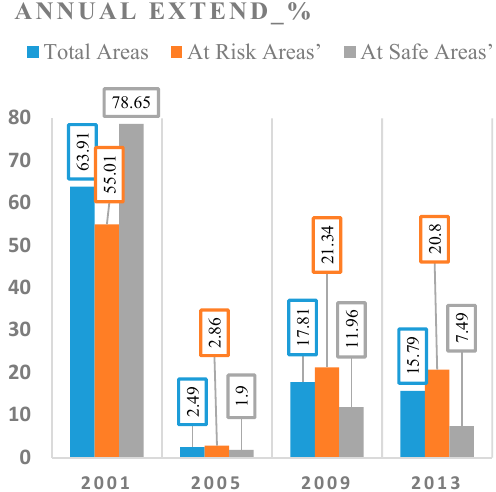
Figure 8. Urban areas from 2001 to 2013.